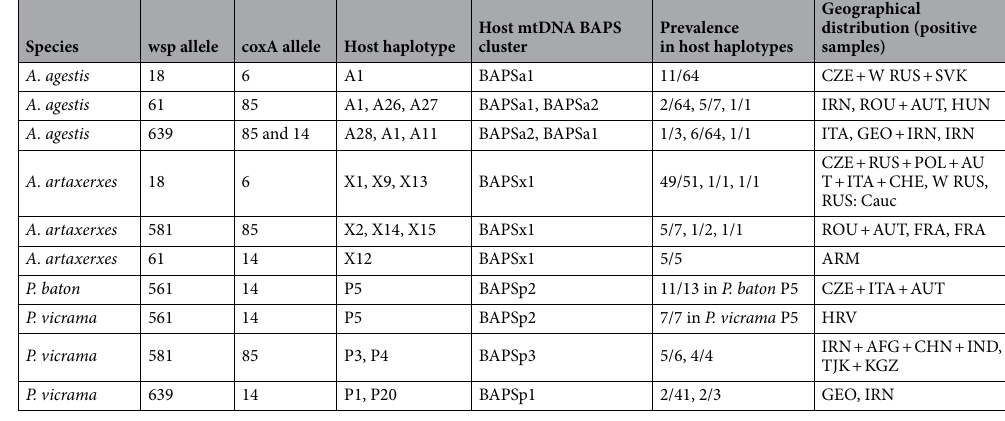
Table 1. Wolbachia wsp and coxA alleles detected in samples of Aricia spp. and Pseudophilotes spp. Country codes accord to ISO-3 standard; W RUS = western Russia, RUS: Cauc = Russia, Caucasus Mts. In A. agestis wsp 639, two samples were recognized as coxA 14 (host haplotype A1, from eastern Iran), one as coxA 85 (host haplotype A1, from Georgia), and in four cases, the sequencing of coxA was not